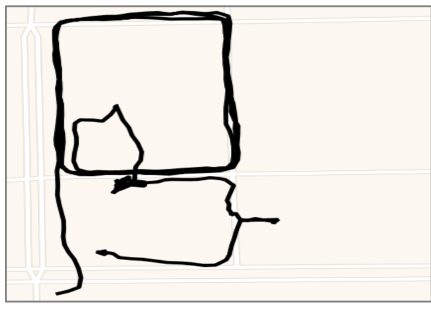
Figure 5. An example of a trajectory of